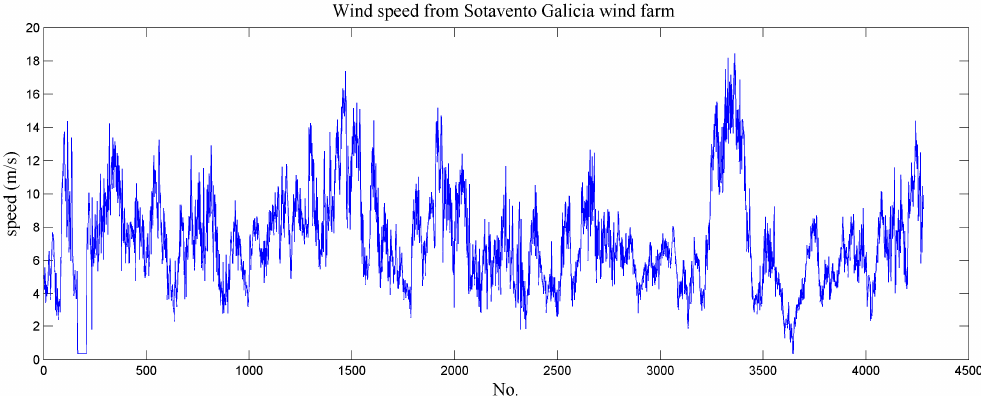
Figure 10. Wind speed time-series of Sotavento Galicia wind farm. Table 5. Statistical information of wind speed from Sotavento Galicia wind farm.